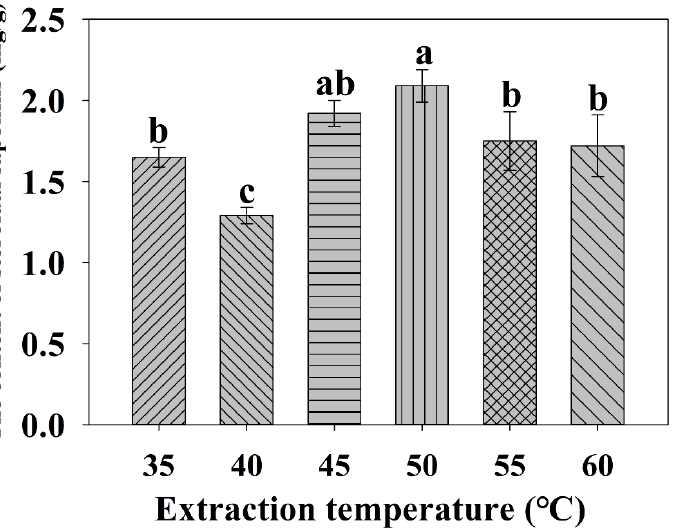
Figure 5. Effect of extraction temperature on the yield of total steroidal saponins. Different lowercase letters represent the difference among treatments of extraction temperature, p ≤ 0.05. Error bars indicate mean values ± SD, ( n = 3).